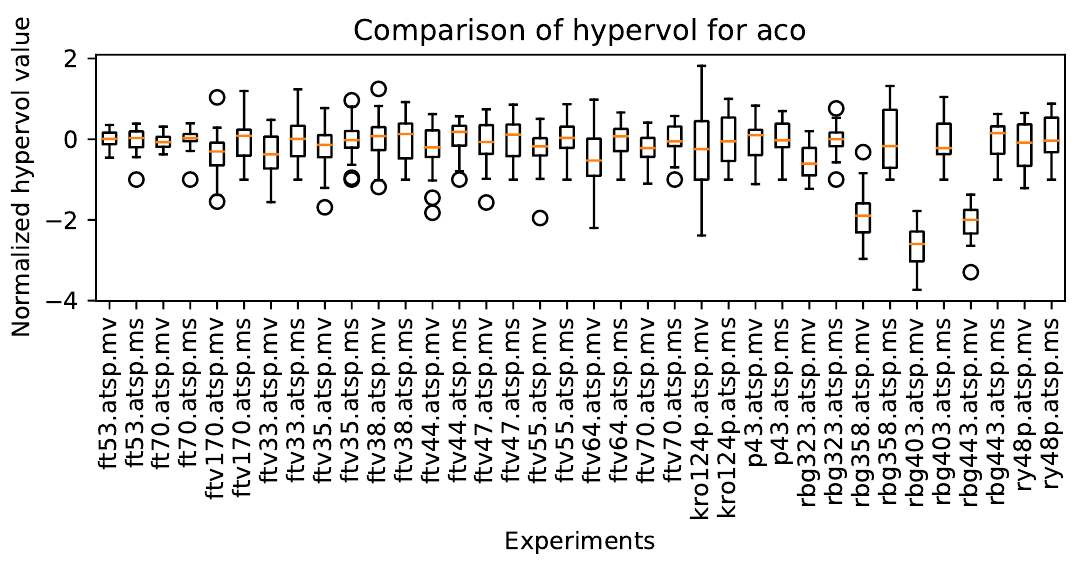
Figure 4. Boxplot of hypervolume across the 25 runs for each instance problem using Multistart and Multiverse Ant Colony Optimziation methods. Hypervolumes are normalized to the corresponding average using Multistart so that they are